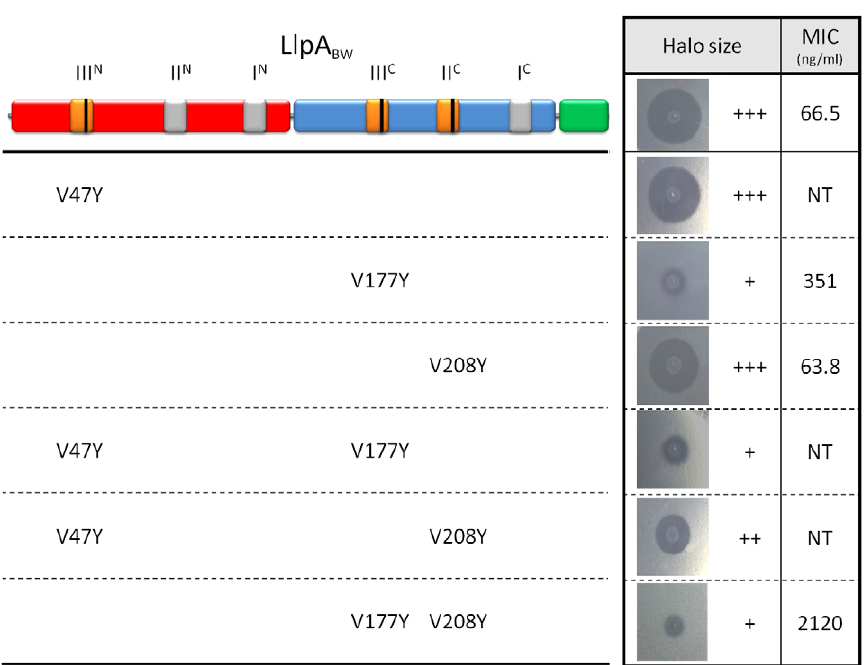
Figure 4. Inhibitory activity of wild-type LlpA BW and selected mutants with modified (potential) mannose-binding sites. The domain structure (N-domain in red, C-domain in blue and C-terminal extension in green) and the position of the MMBL motifs (potentially active binding sites in orange, inactive ones in grey) are shown. The positions of conserved valine residues converted to tyrosine residues by site-directed mutagenesis are indicated with a black bar. Inhibitory activity of E. coli strains expressing mutant LlpA BW forms was assayed against P. syringae GR12-2R3 and semi- quantified according to the size (inner zone radius) of the growth inhibition halo relative to LlpA BW ( +++ , native LlpA BW ; ++ , halo size reduced; + halo size strongly reduced; 2 , no halo; NT, not tested). For wild-type LlpA BW and three purified His-tagged mutant forms (LlpA V177Y , LlpA V208Y and LlpA V177Y-V208Y ) the MIC values were determined with indicator P. syringae GR12-2R3. Molar minimal inhibitory concentrations of recombinant proteins (with standard deviations): LlpA, 2.08 nM ( 6 0.58 nM); LlpA V177Y , 10.9 nM ( 6 0.66 nM); LlpA V208Y , 1.98 nM ( 6 0.066 nM); 65.72 nM